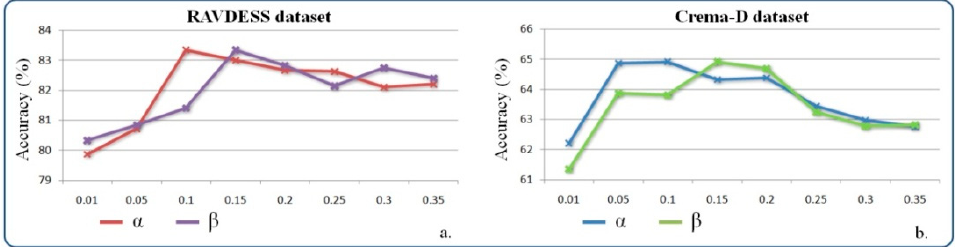
Figure 11. The system performance evaluation for different values of the control margins α and β on ( a ) RAVDESS dataset; ( b ) CREMA ‐ D dataset